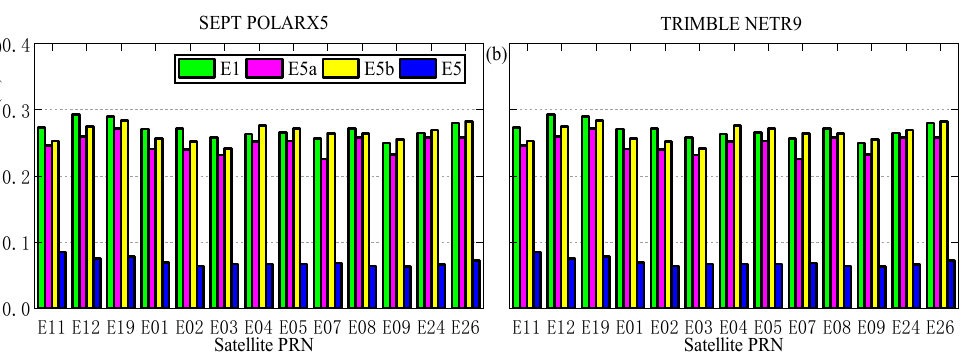
Figure 8. RMS of MPC for different satellites from the different receiver types ( a ): SEPT POLARX5, ( b ): TRIMBLE NETR9.